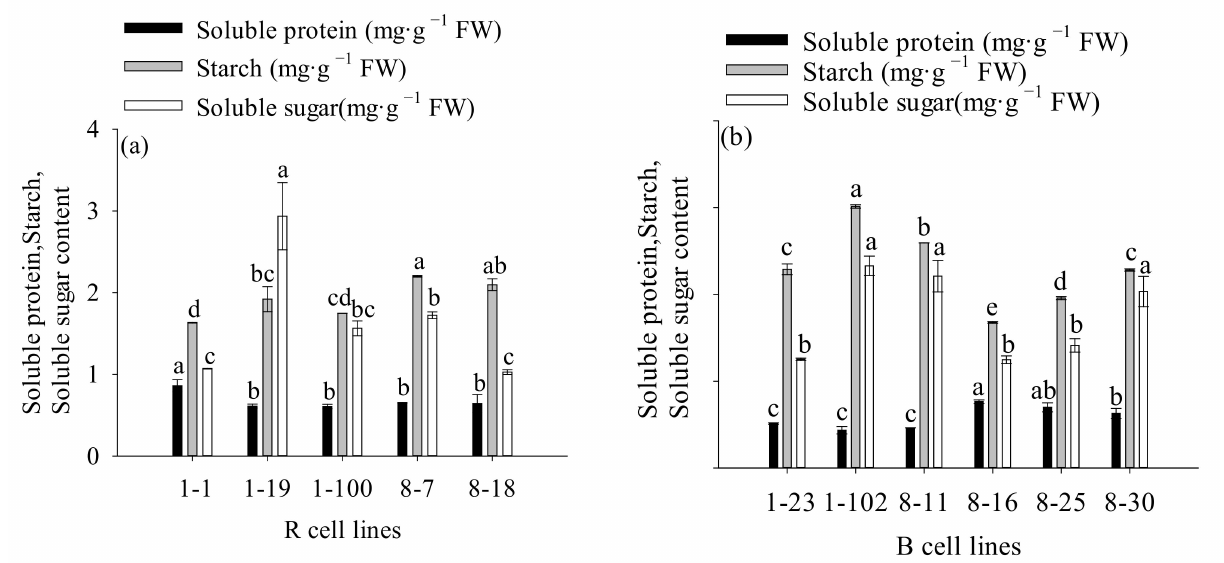
Figure 9. Differences in soluble sugar, starch, and soluble protein contents between different cell lines of P. koraiensis . ( a ) R cell lines; ( b ) B cell lines. Different letters above the bar indicate significant differences at the p < 0.05